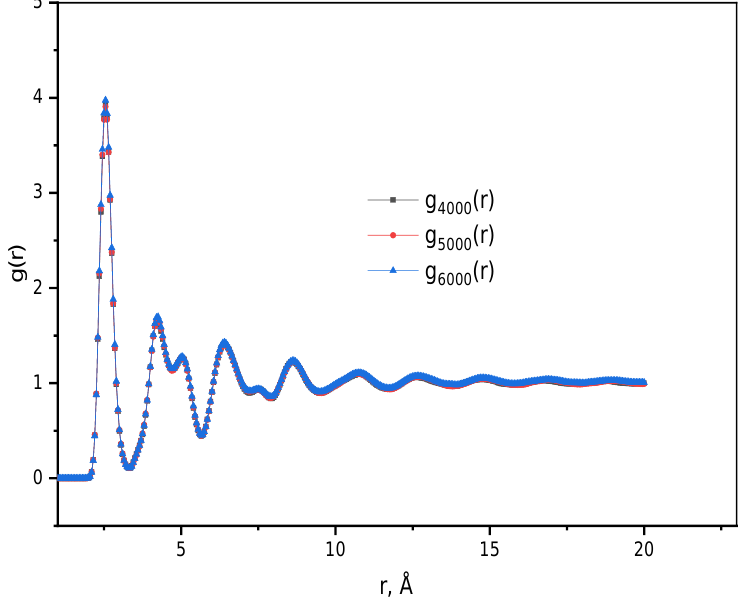
Figure 2. PRDF for 4000, 5000, 6000 atoms sample at 300